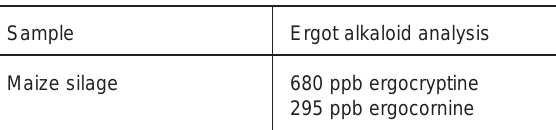
TABLE 4 Ergot alkaloid level of maize silage in the second out- break